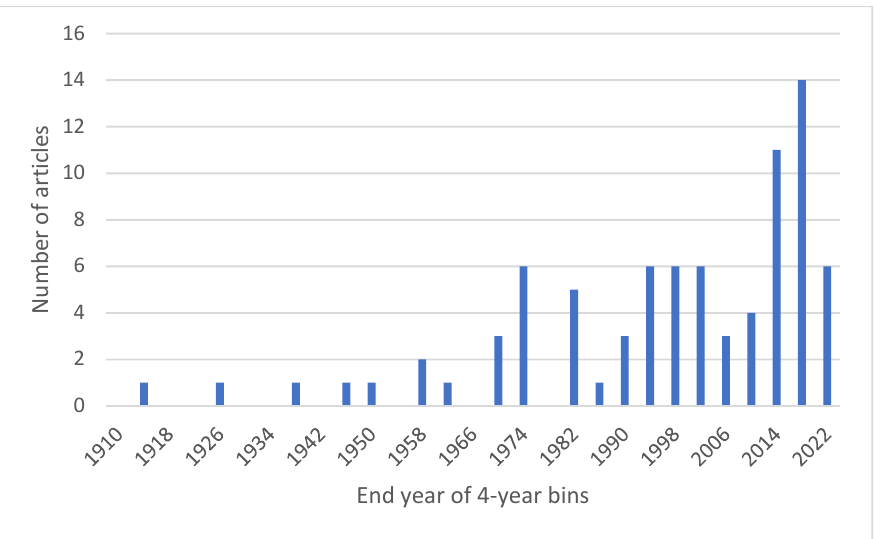
Figure 4. The distribution of publication dates of the literature cited in this review. There were 87 articles in total. The Yara website, two anonymous articles, and two web pages were not included. The count from 2022 is incomplete and represents a count from less than half the chronological year.